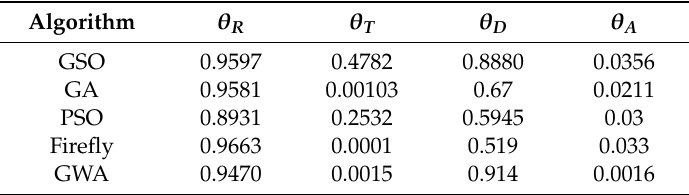
Table 8. Example 1: Tuning parameters with an optimization